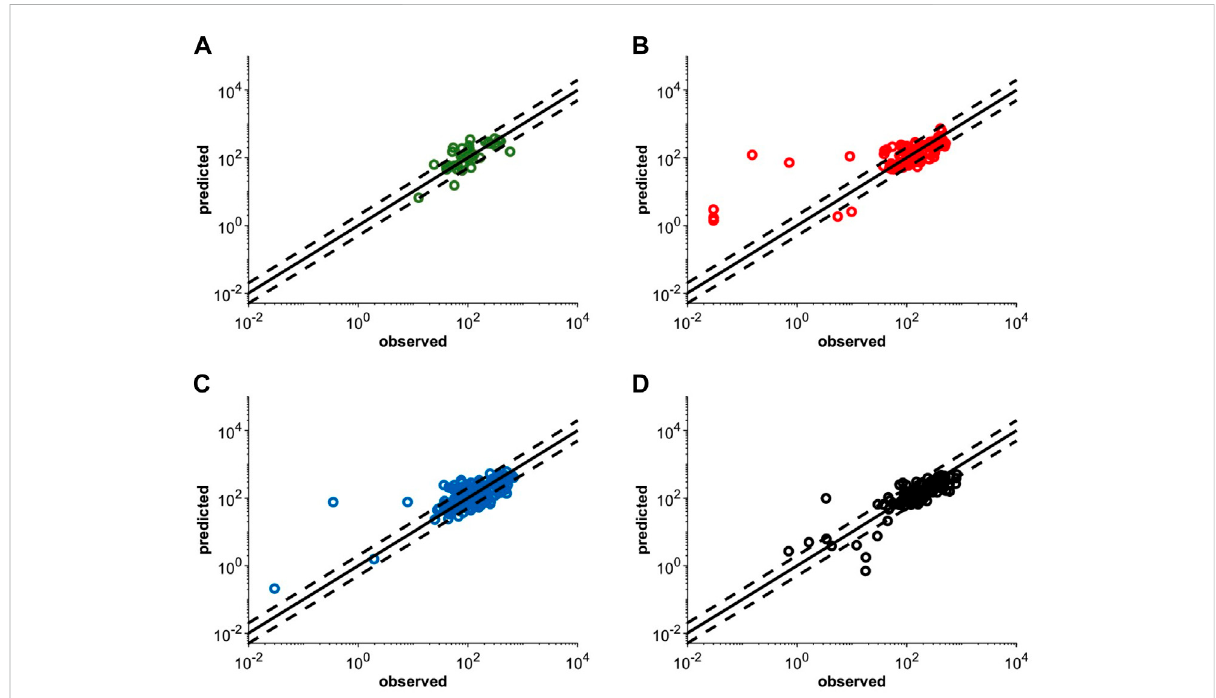
FIGURE 5 Individualized simulated mean and observed (Shemesh et al., 2019) plasma concentrations following multiple IV doses of 15 mg/kg ( < 18 yo) or 1,200 mg( ≥ 18 yo)atezolizumabQ3Winpediatricpatients (A) 0 – 6 yo, (B) 6 – 12 yo,and (C) 12 – 18 yoor (D) youngadultpatientswithsolidtumorsand hematologic malignancies. The solid black lines represent the line of unity and the dashed black lines represent the 2-fold error margin. Each simulation matched the dosing information and demographics with each enrolled